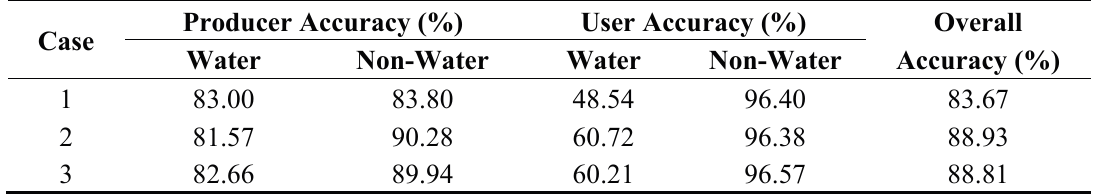
Table 3. The water classification results using terrain information.